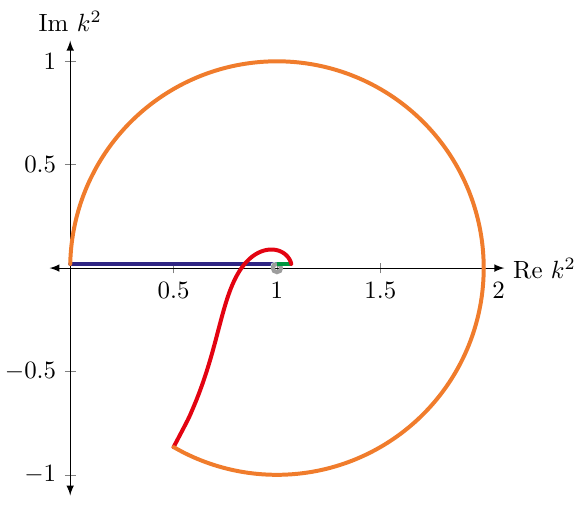
Figure 3 . The path in k 2 -space. The path wraps in a small circle around the point k 2 = 1 .